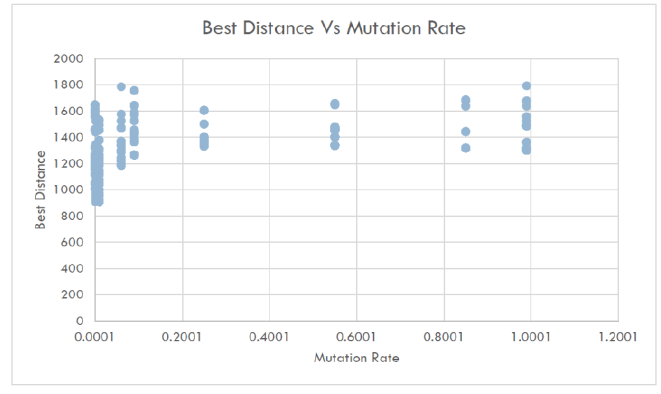
Fig. 4. Route Best Distances Compared to Mutation